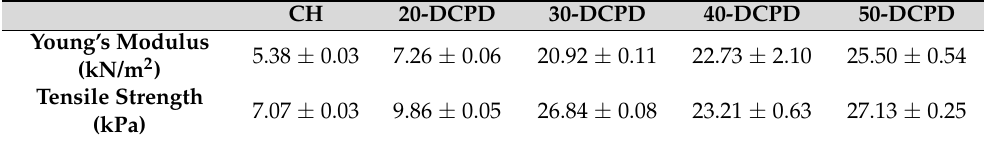
Table 3. Mechanical property data was obtained from tensile testing freeze-dried scaffolds (n = 3).